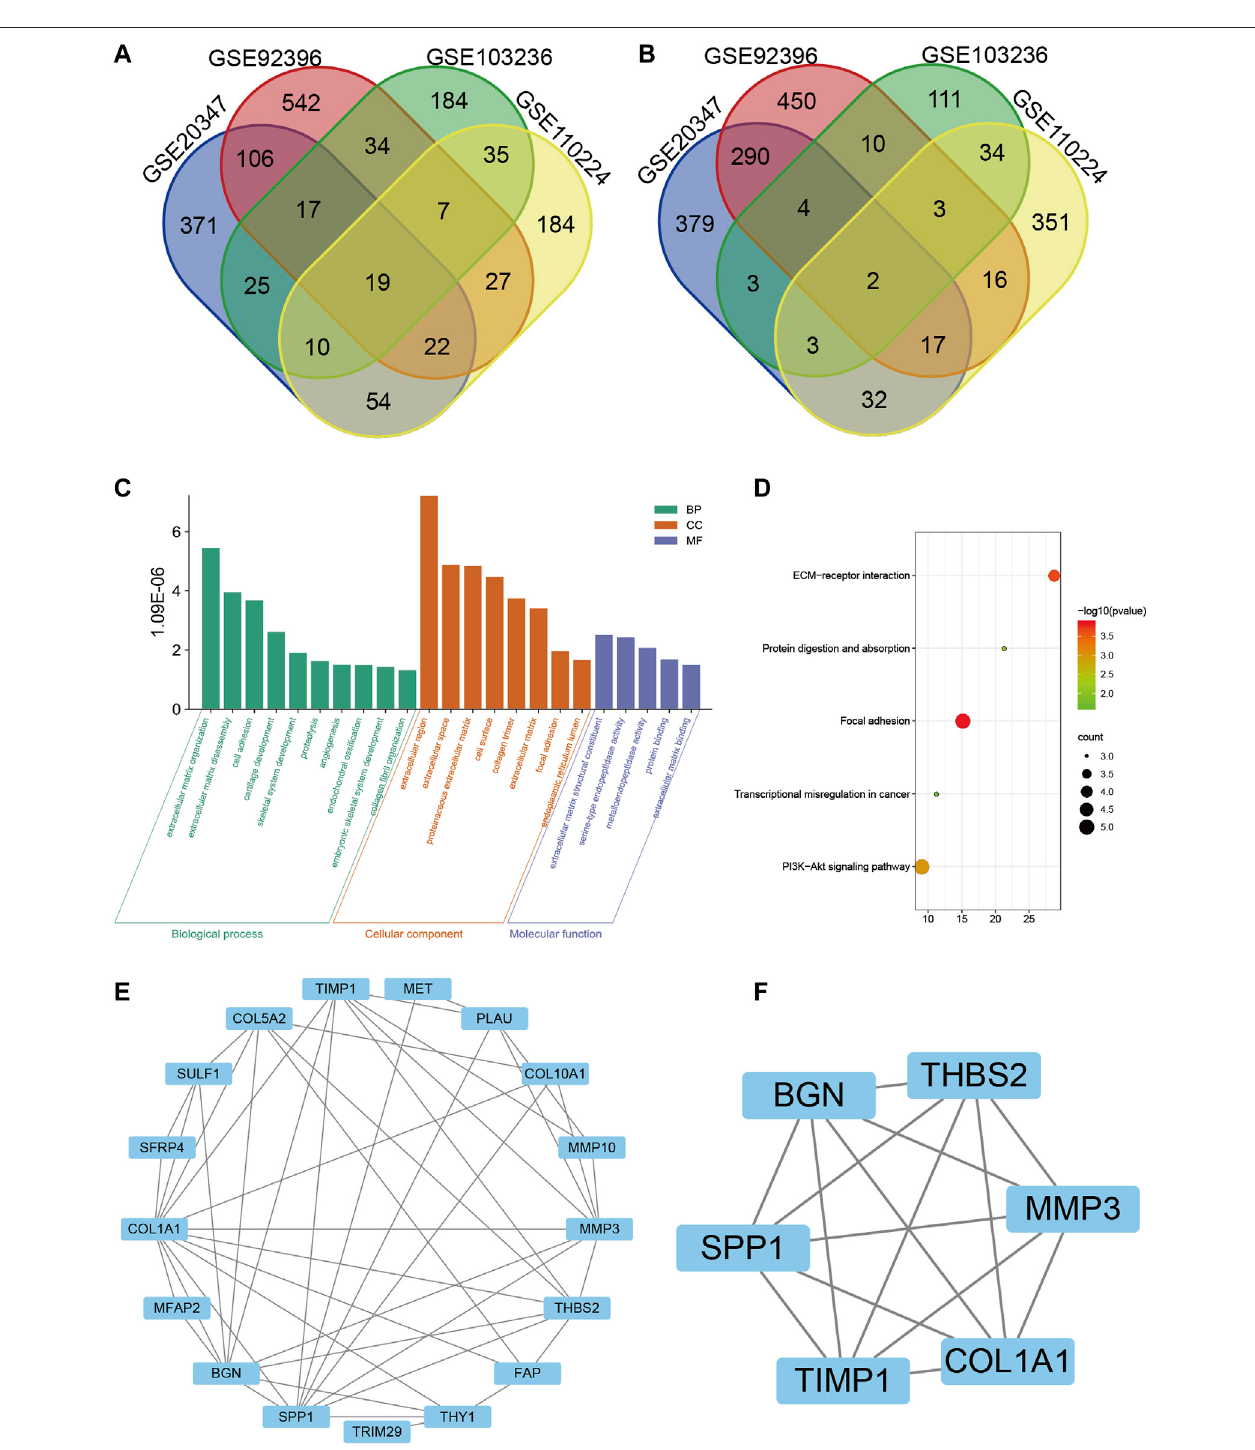
FIGURE 1 | Identi fi cation of 21 differentially expressed genes (DEGs) from four microarrays (GSE20347, GSE92396, GSE103236, and GSE110224) of gastrointestinal cancers, among which 19 were upregulated and 2 were downregulated. (A) Upregulated genes. (B) Downregulated genes. (C) Gene Ontology (GO) analysisofDEGs,including biologicalprocess(BP),cellular component(CC), and molecular function(MF), respectively. (D) Kyoto EncyclopediaofGenesand Genomes (KEGG) pathway analysis of DEGs. (E) Protein – protein interaction (PPI) network of DEGs by Cytoscape. (F) Interaction network of hub genes, including SPP1 , BGN , THBS2 , MMP3 , COL1A1 , and TIMP1